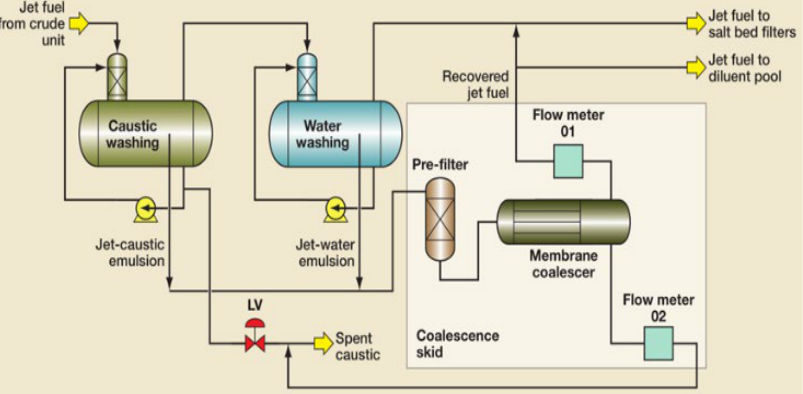
Figure 17. Process scheme for recovering jet fuel from emulsions [198]. Reproduced from Hernando Salgado, et al., 2014 (ref. [198]).